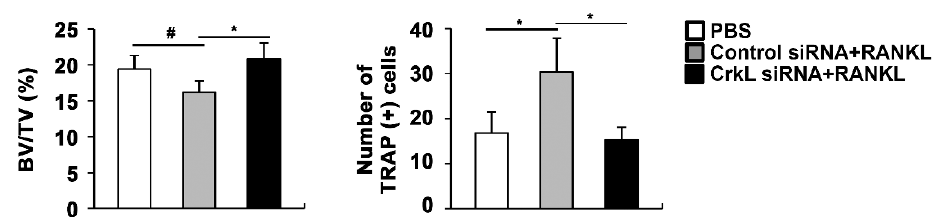
Figure 5. CrkL knockdown prevents RANKL-induced bone loss. Bone volume to tissue volume (BV/TV) and the number of TRAP-positive cells in the murine calvarial model treated with PBS, RANKL and control, or CrkL siRNA. # p < 0.05; * p < 0.01 as compared with the controls.